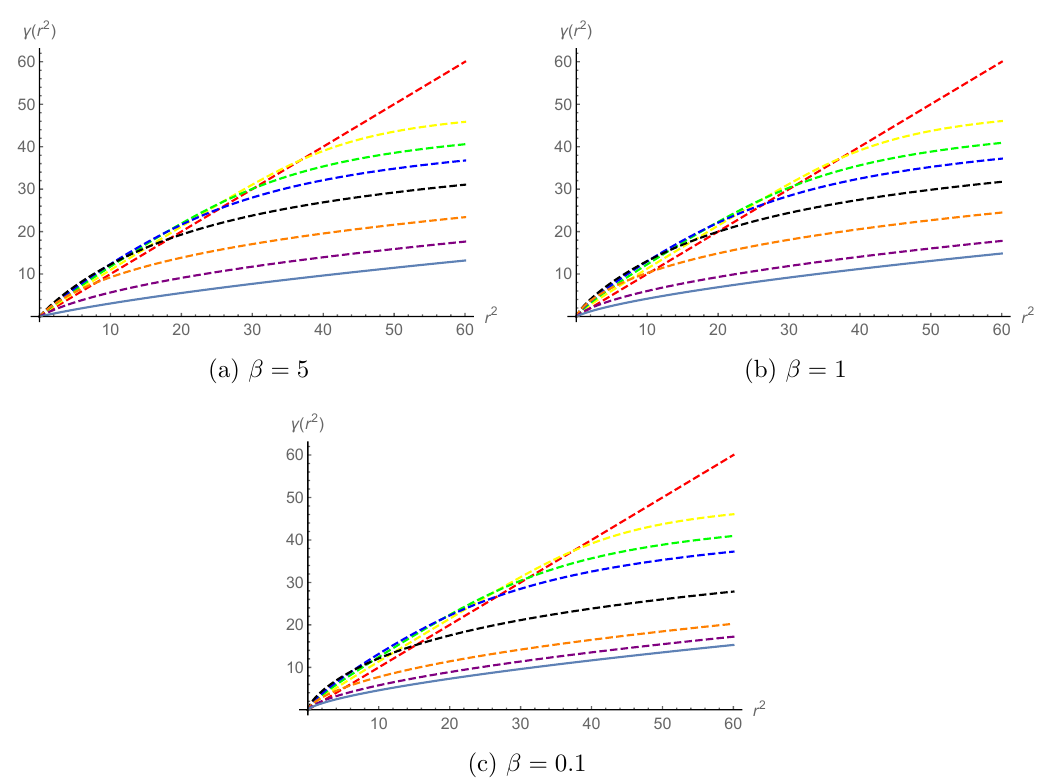
Figure 8. Test at larger ~ r 2 of convergence of the IR (cid:13)ow of (cid:13) (~ r 2 ) from the starting UV point (cid:13) = ~ r 2 (red dashed line) to the analytic IR solution (solid blue line). From top to bottom dashed lines (yellow to purple) represent the intermediate K(cid:127)ahler potentials from the early RG time to the late RG